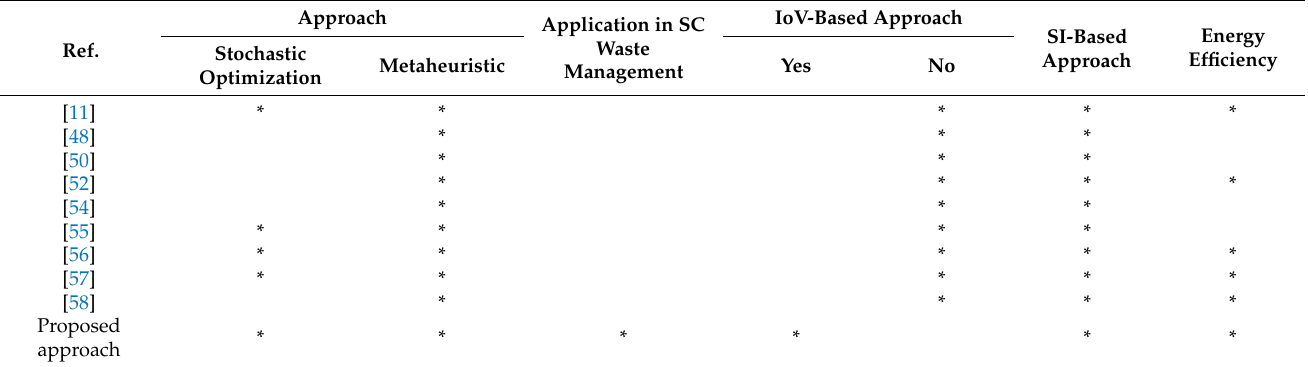
Table 2. Comparison of the proposed approach with other SI-based